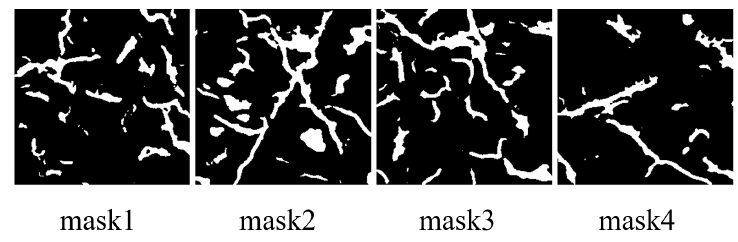
Figure 10. Crack masks diagram.